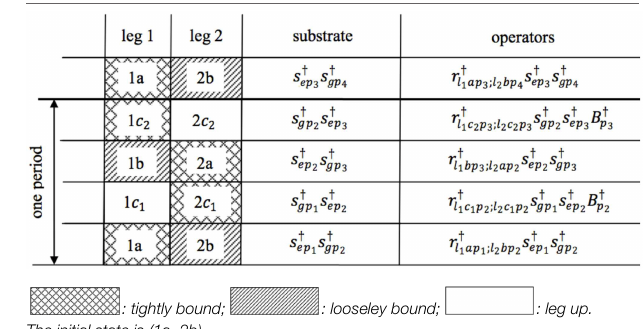
TABLE 1 | Representation of the motion patterns of a “leg-over-leg” walking process of a molecular robot r .